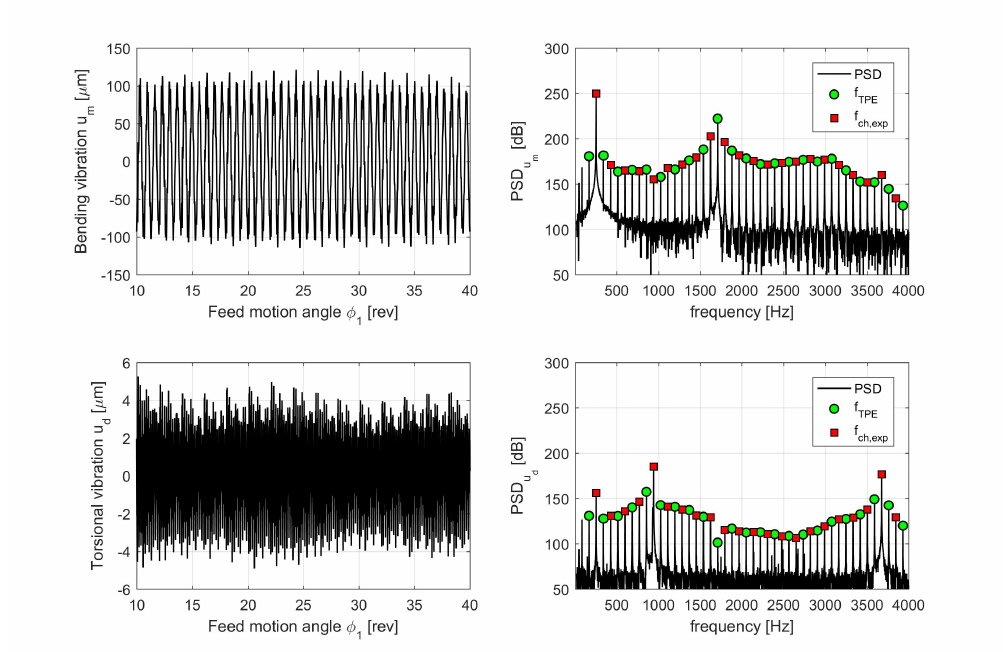
Figure 14. Behavior in time and frequency domain of blade tip vibrations under flip chatter type, dominated by the first bending vibration mode. Blade type: lattice (without powder). Cutting parameters: n = 10,250 rpm, a p = 0.5 mm. Blade vibrations are derived from dynamometer signals. TPE = tooth pass excitation